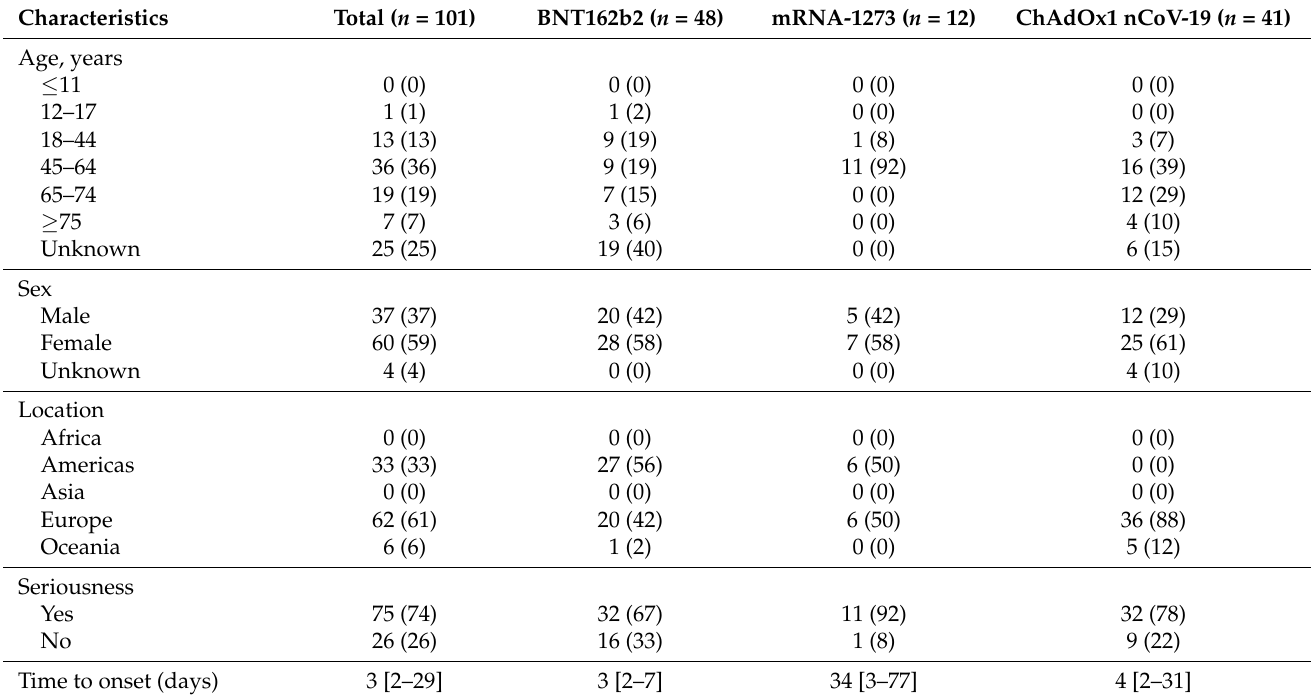
Table 1. Demographics and characteristics of reported cases with systemic capillary leak syndrome (SCLS) according to type of COVID-19